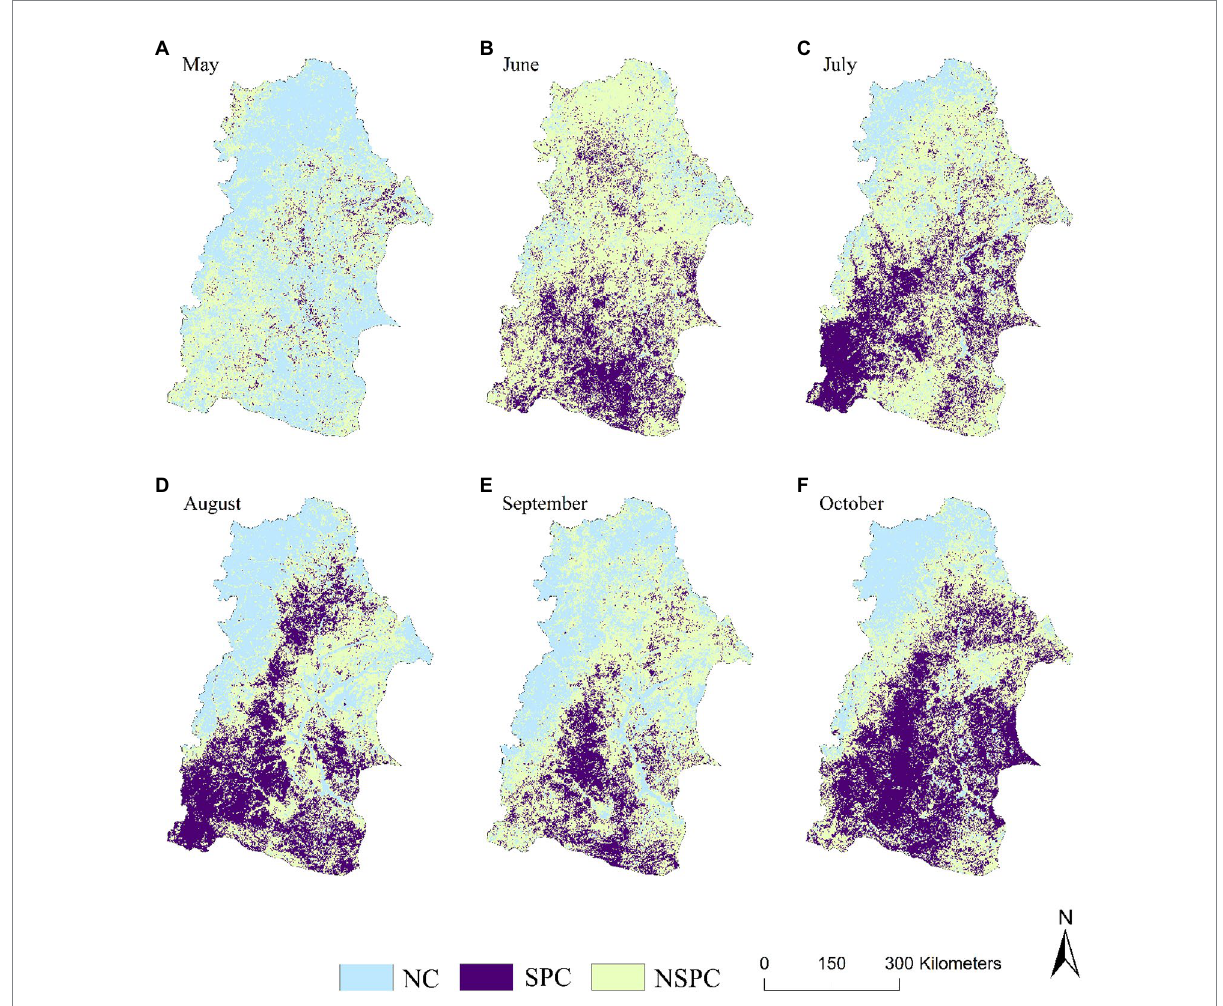
FIGURE 8 Spatial distributions of correlative level between the NDVI and SPEI lagged period effect at the monthly